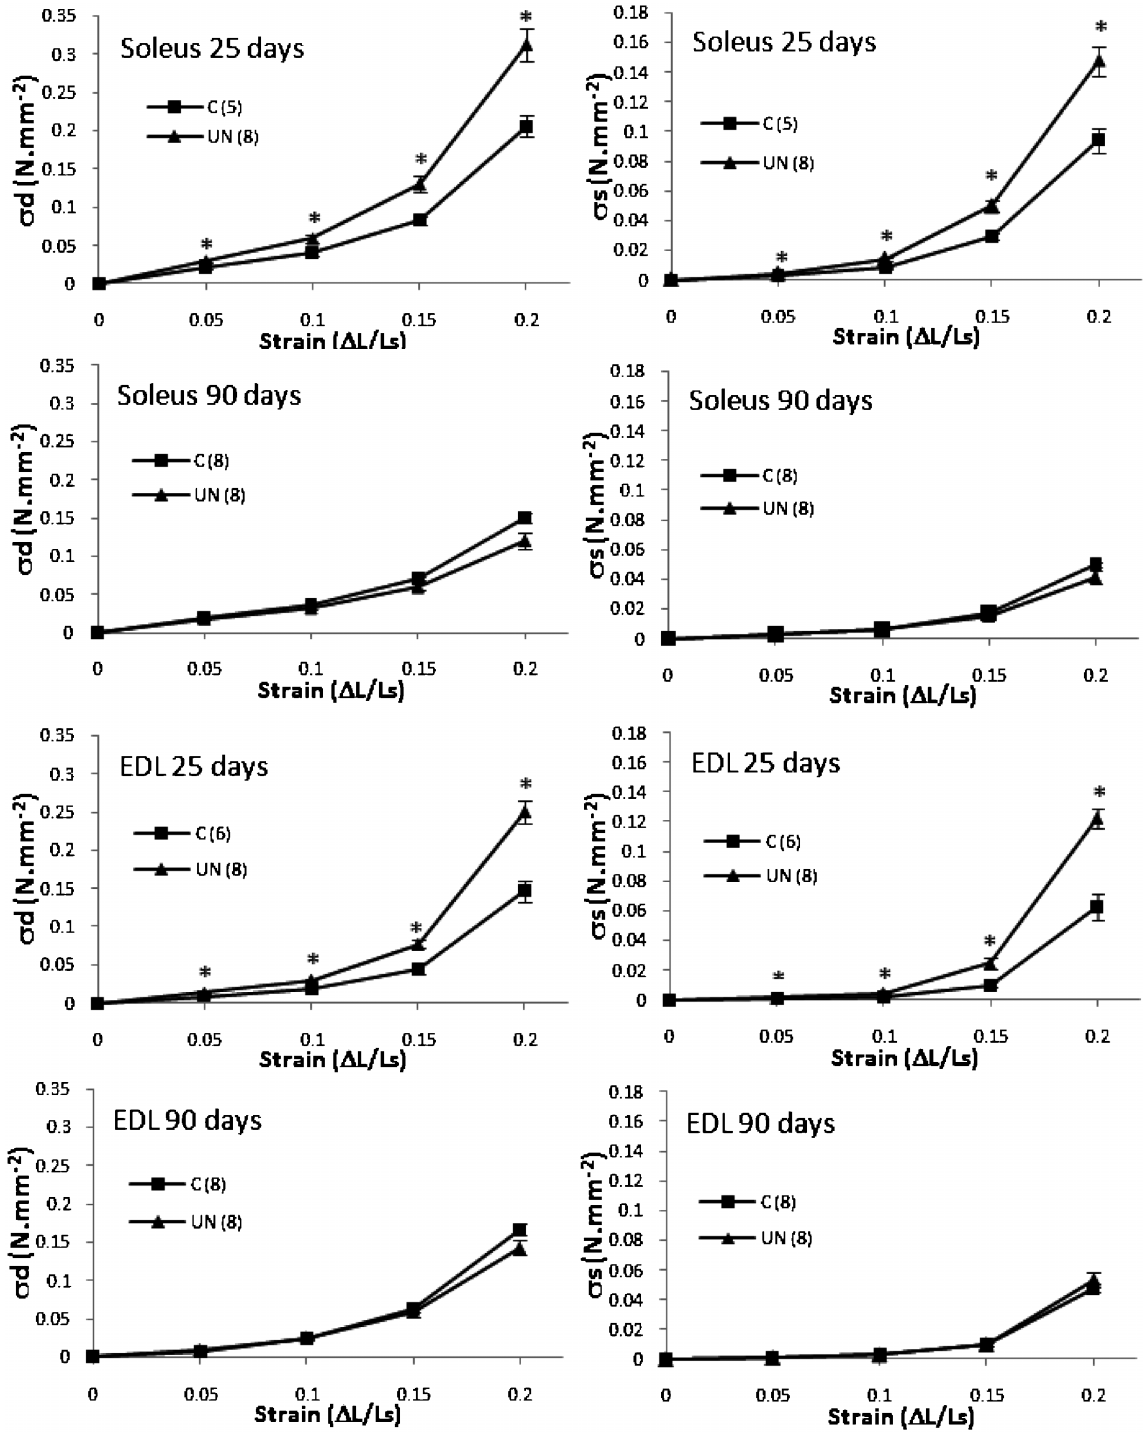
Figure 4 - Effects of undernutrition on dynamic tension ( s d ) (left) and steady tension ( s s ) (right) in soleus and EDL muscles at 25 and 90 days of age induced by incremental stepwise extensions. C: control group; UN: undernourished group. The number of muscles is indicated in parentheses. *p , 0.05 vs